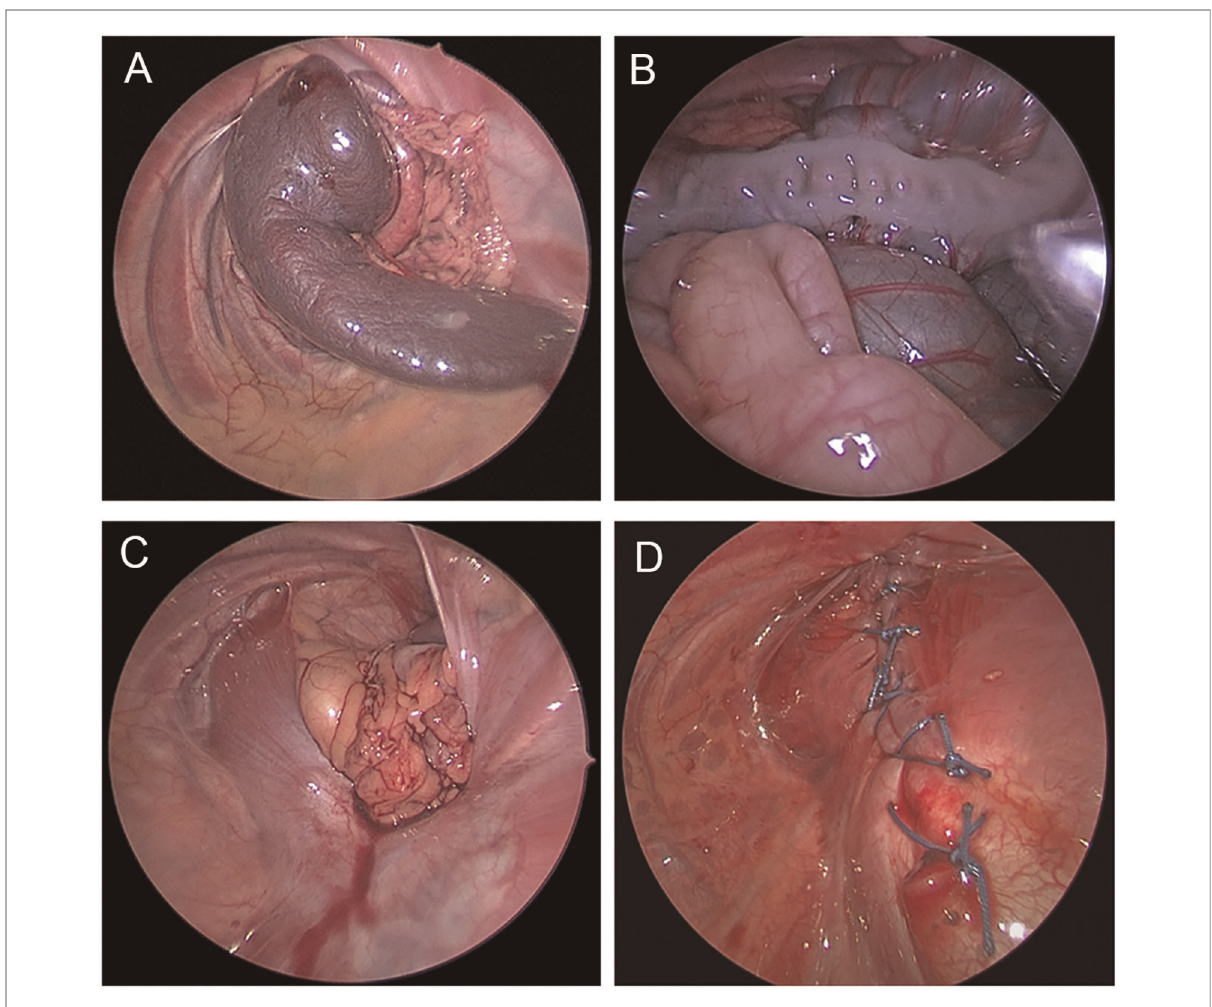
FIGURE 1 Thoracoscopic repair of congenital diaphragmatic hernia. ( A ) Herniation of the spleen into the chest cavity. ( B ) Herniation of the spleen, colon, and small intestine into the thoracic cavity. ( C ) Diaphragmatic defect after reduction of the contents. ( D ) Suture line after thoracoscopic diaphragmatic hernia